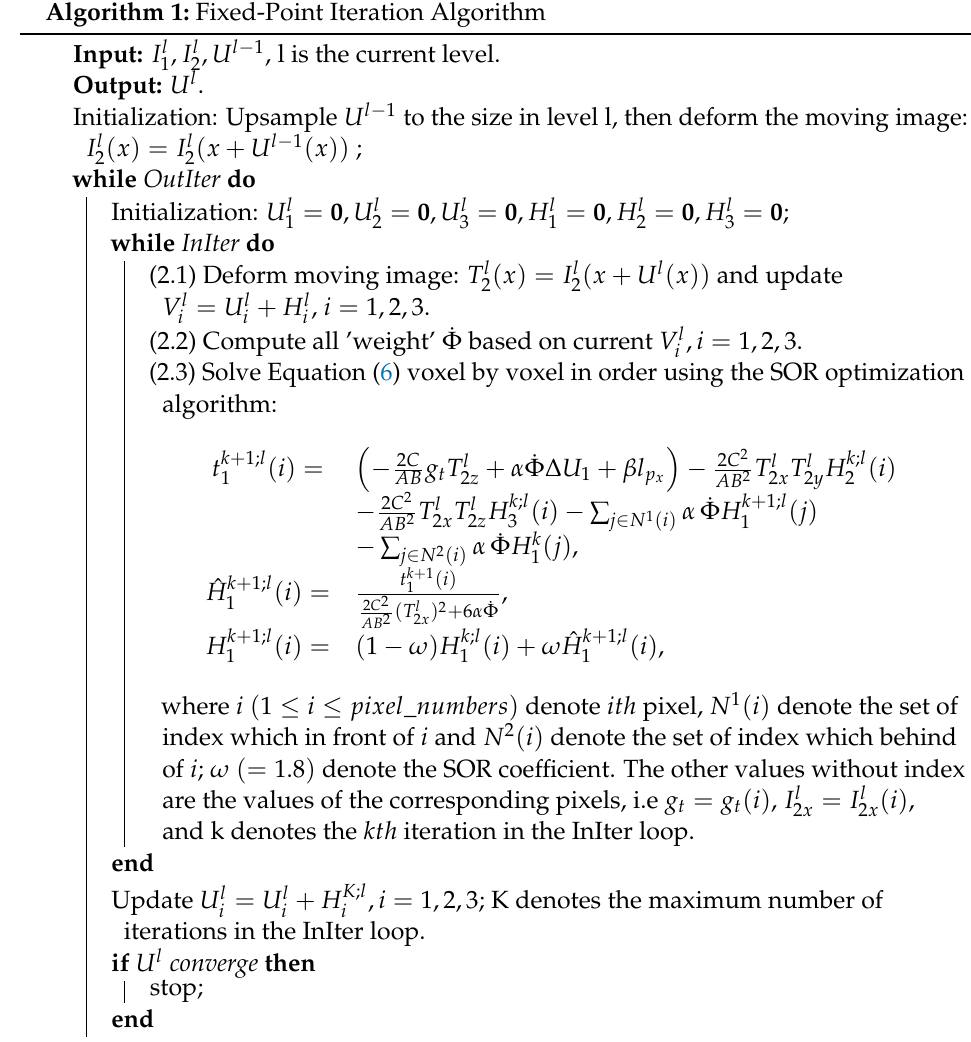
Algorithm 1: Fixed-Point Iteration